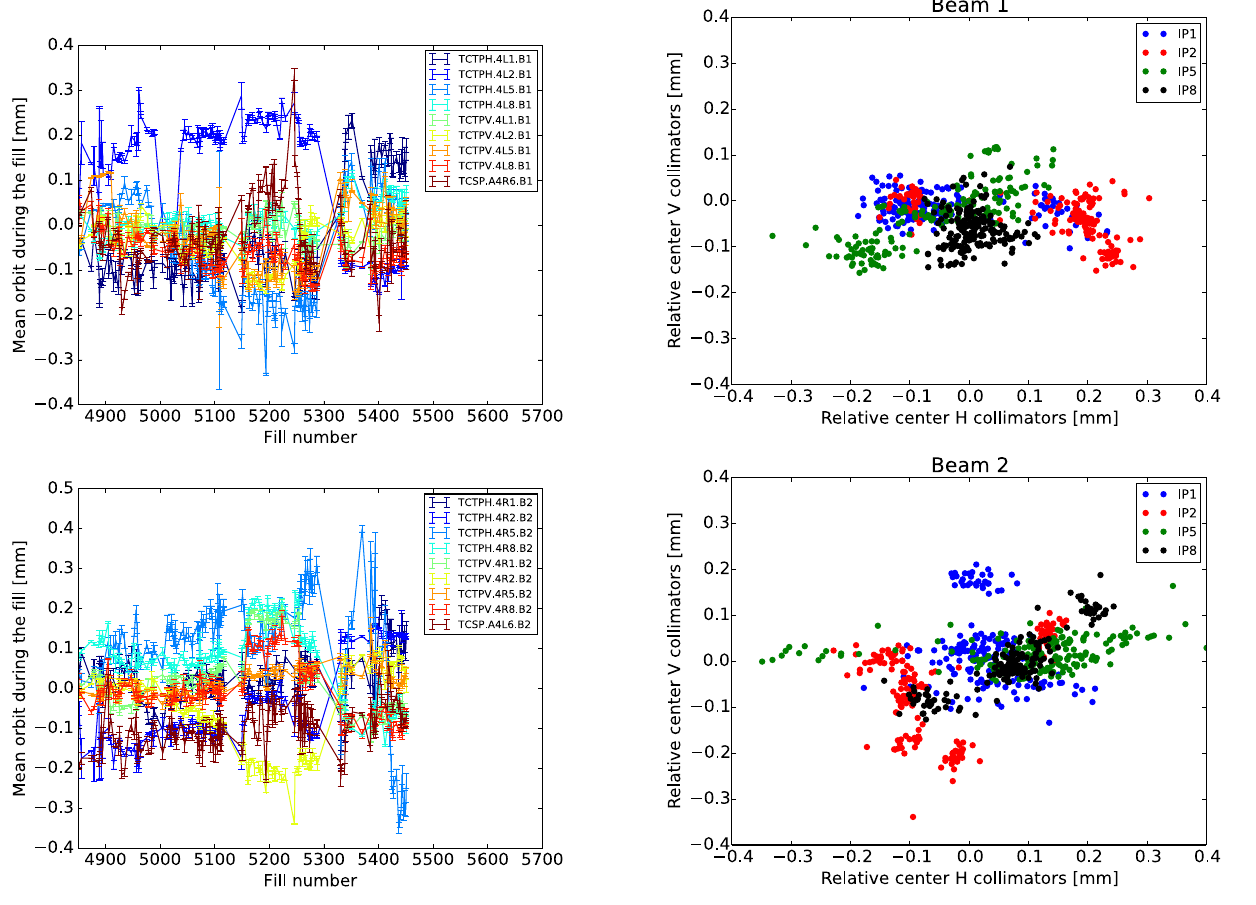
FIG. 19. The average beam positions measured during the stable beams period each proton physics fill in 2016, together with the standard deviation as the error bar, for B1 (top) and B2 (bottom) collimators.